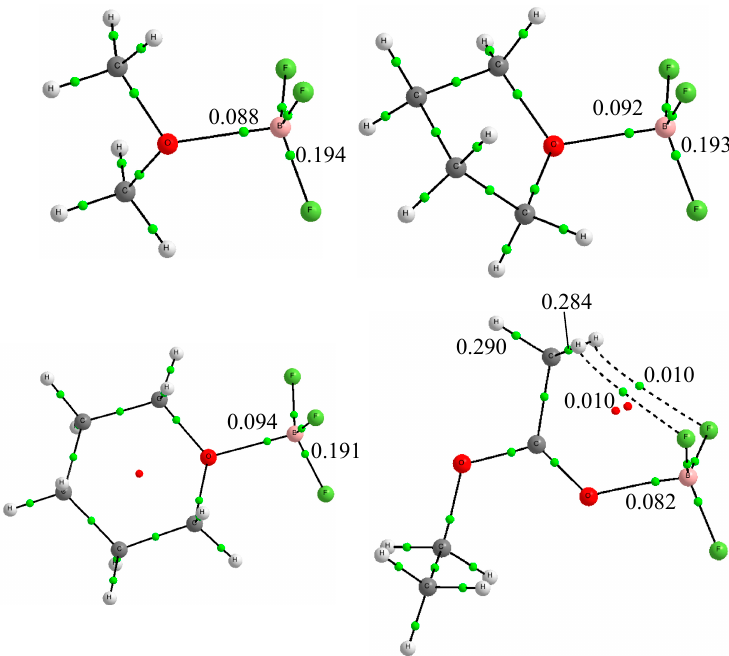
Figure 1. Molecular graphs for the complexes between dimethyl ether, tetrahydrofuran, tetrahydropyran and ethyl acetate with BF 3 . The green dots show the positions of the bond critical points, whose electron density in a.u. is indicated for relevant cases.